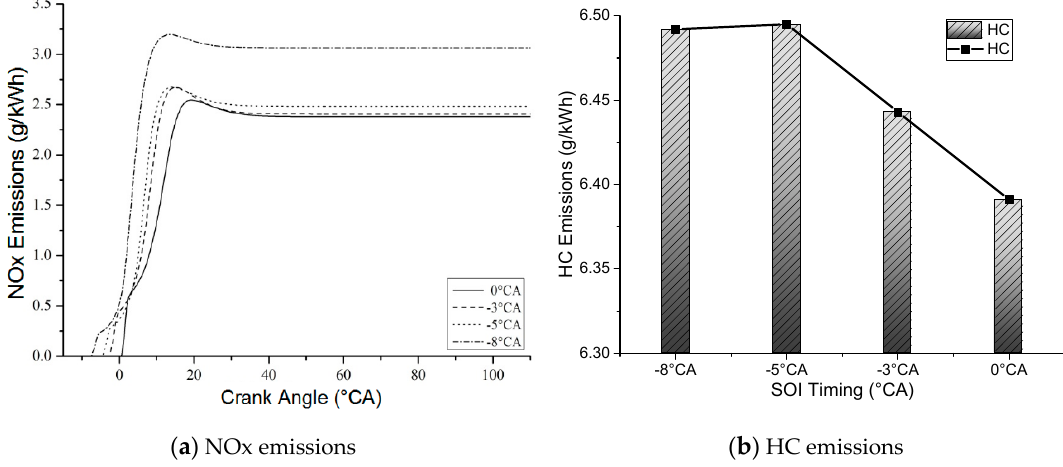
Figure 17. NOx and HC emissions under different pilot SOI timing.